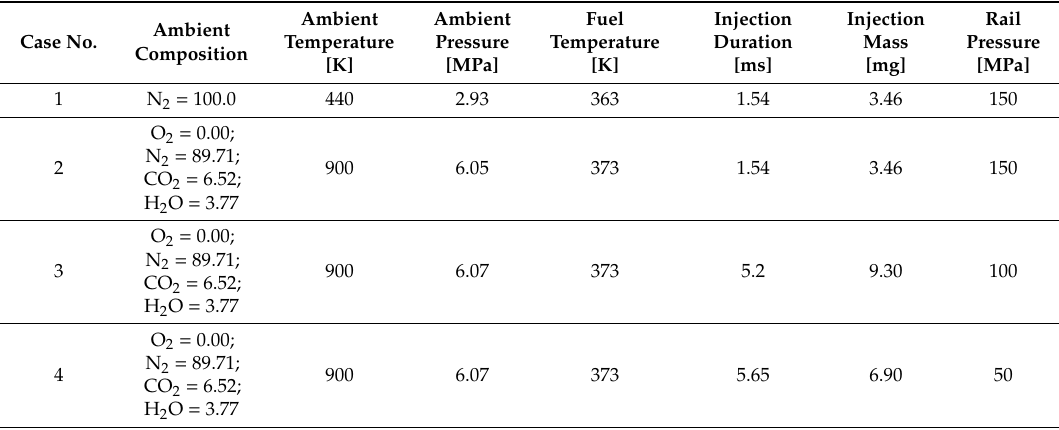
Table 2. The Operating Conditions of the Test